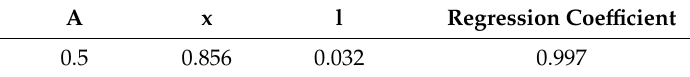
Table 4. Fit parameters of the fraction of processes.